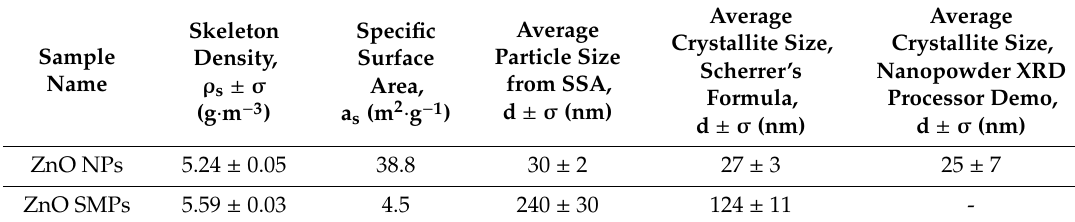
Table 1. Characteristics of ZnO NPs and ZnO SMPs.